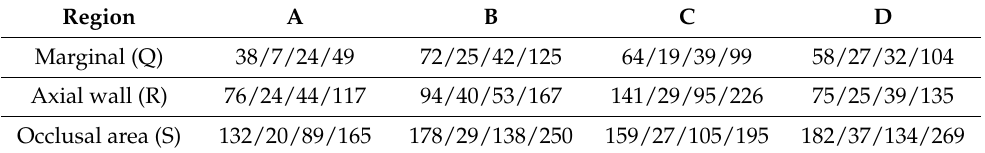
Table 4. Mean gap size with standard deviation, minimum and maximum, according to region ( µ m). Region A B